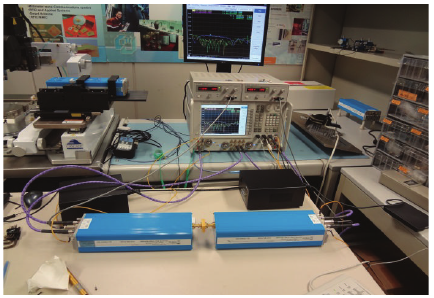
Figure 11: 325 ∼ 500 GHz 𝑆 -parameter measurement setup.